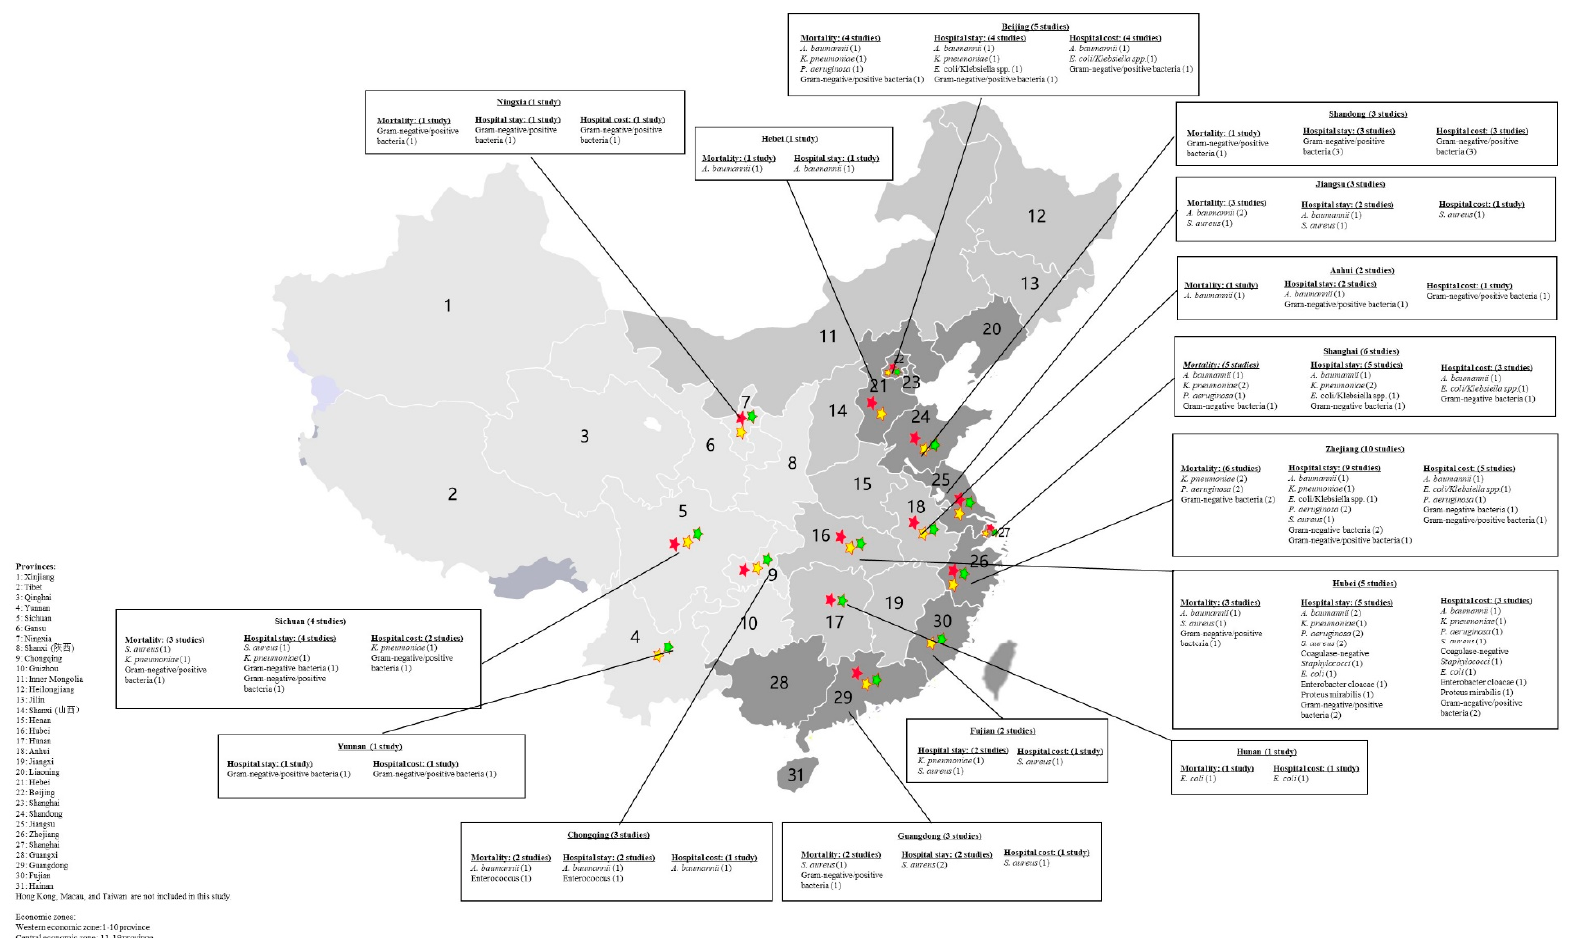
Figure 2. Graphical representation of antibiotic resistance in mainland China in this study. S. aureus : Staphylococcus aureus ; K. pneumoniae : Klebsiella pneumoniae ; A. baumannii : Acinetobacter baumannii ; P. aeruginosa : Pseudomonas aeruginosa ; E. coli : Escherichia coli .